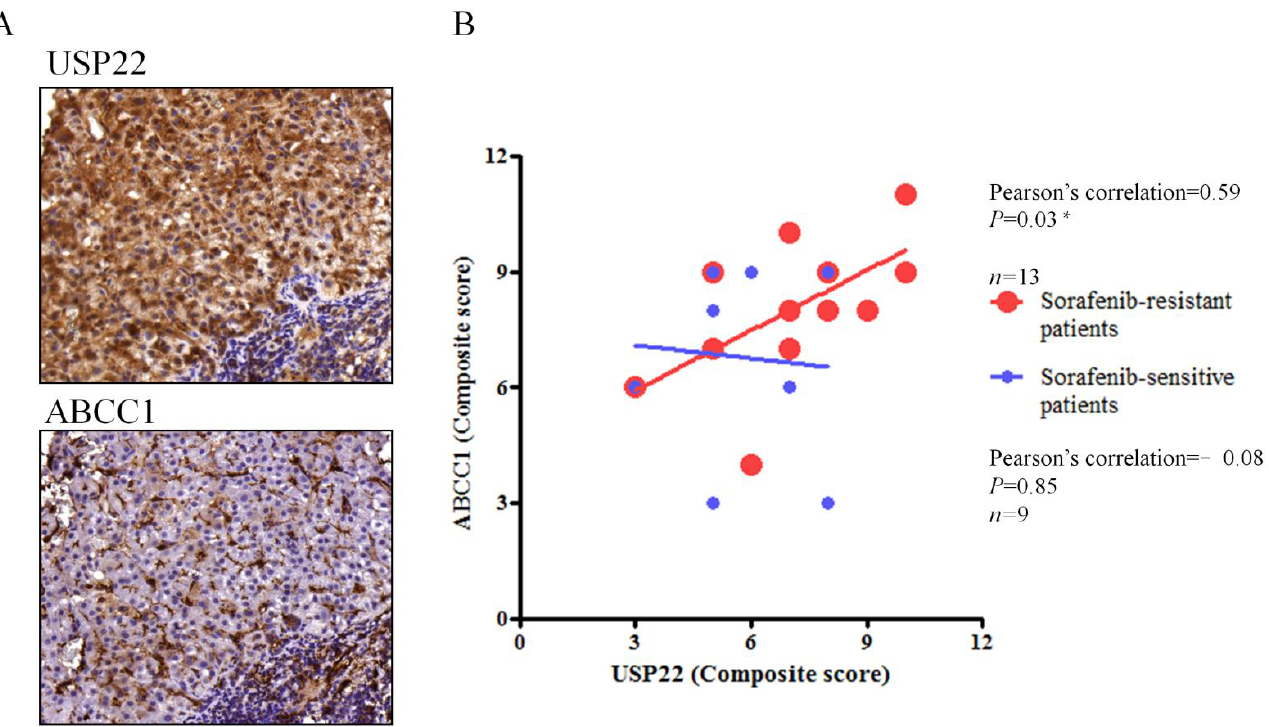
Figure 4. Positive correlation of USP22 and ABCC1 expression levels in sorafenib-resistant HCC tissues. ( A ) USP22 and ABCC1 expression detected by IHC staining of primary HCC. ( B ) Positive correlation between USP22 ( x − axis) and ABCC1 ( y − axis) H-scores based on IHC. *: p < 0.05 compared with sorafenib-sensitive patients group.